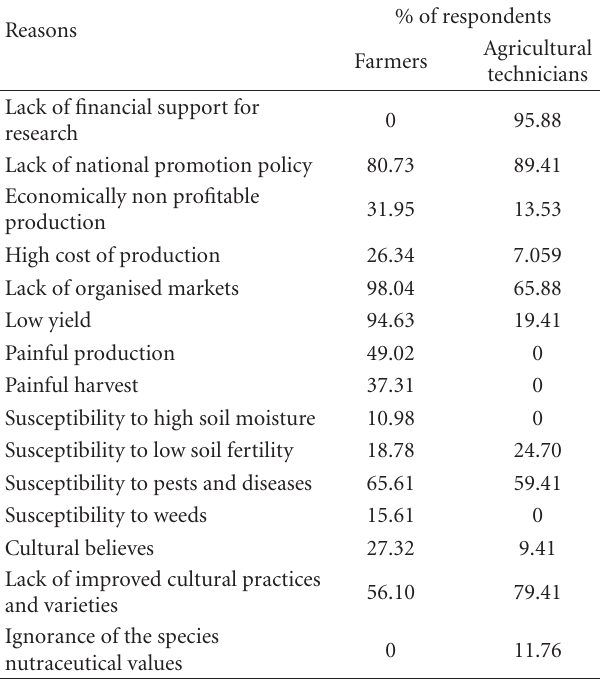
Table 4: Reasons of neglect of the neglected and underutilised crop species and their relative importance according to farmers and the agricultural